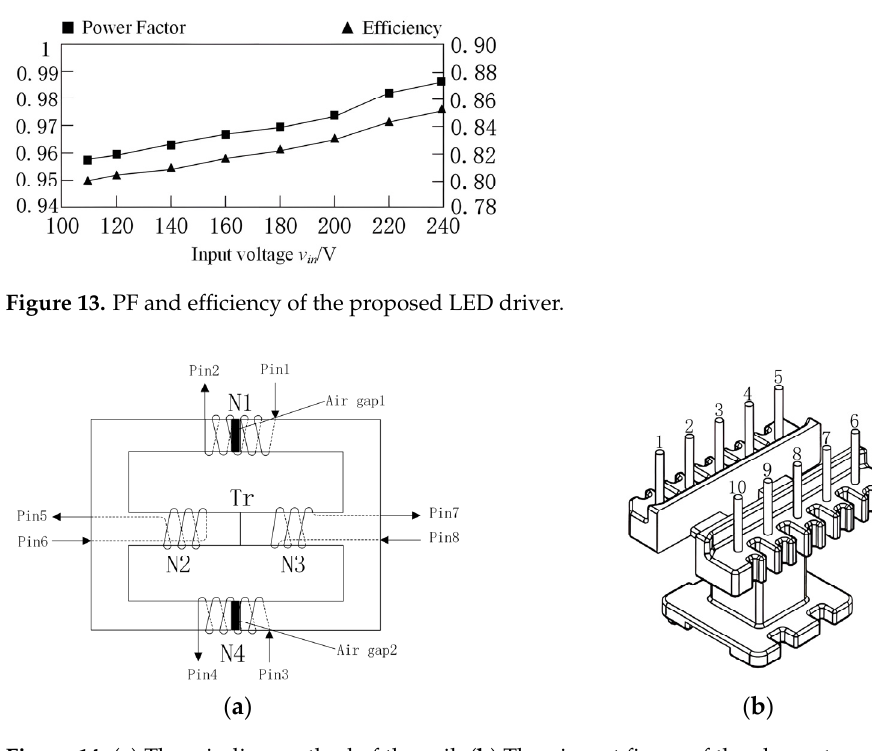
Figure 14. (a) The winding method of the coil. (b) The pin-out figure of the element.